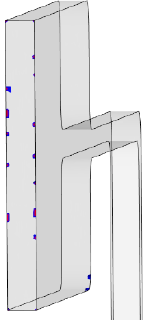
Figure 3. Air traps witnessed in Polypropylene (PP) simulations.